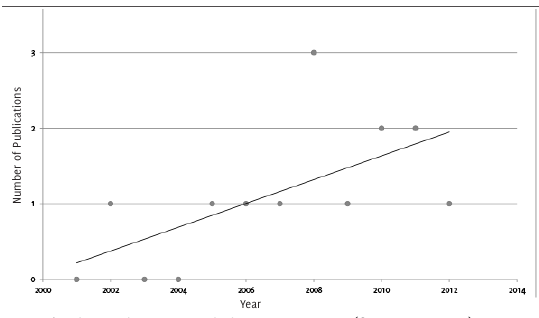
Linear fit obtained using simple linear regression (ß1=0.16,